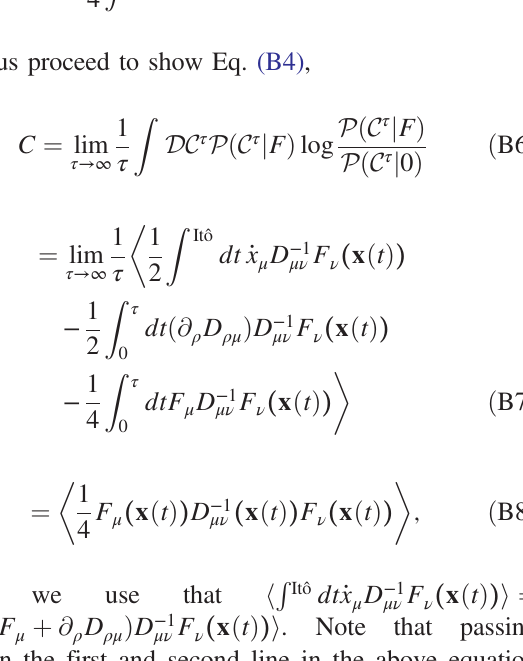
ffiffiffiffiffiffiffiffiffiffiffiffiffi p 2 D ð x Þ